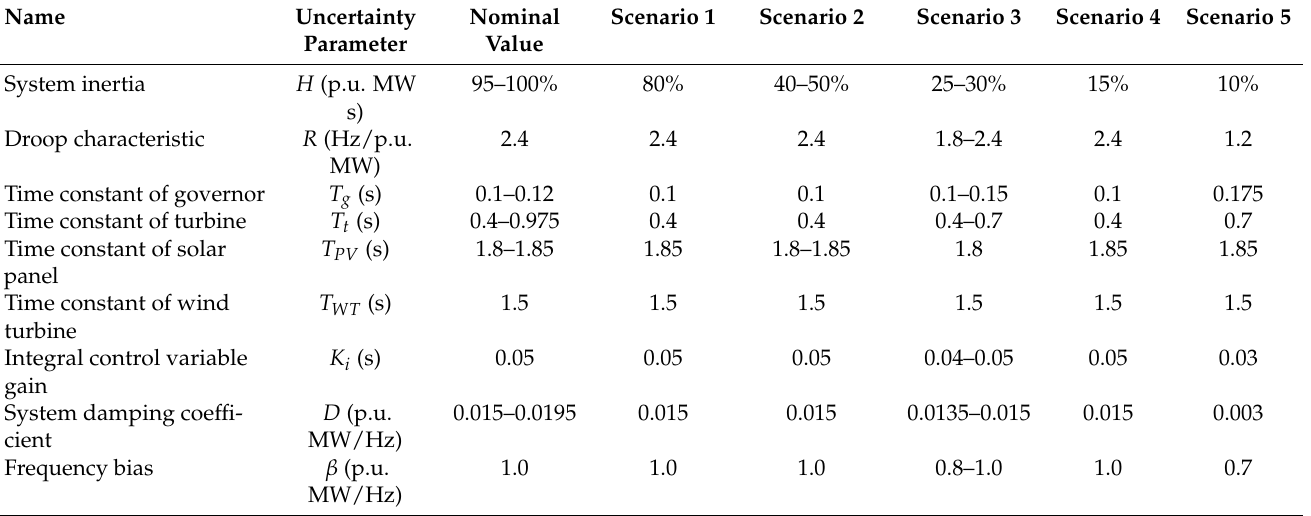
Table 2. Nomenclature: dynamic parameters of islanded microgrids in different